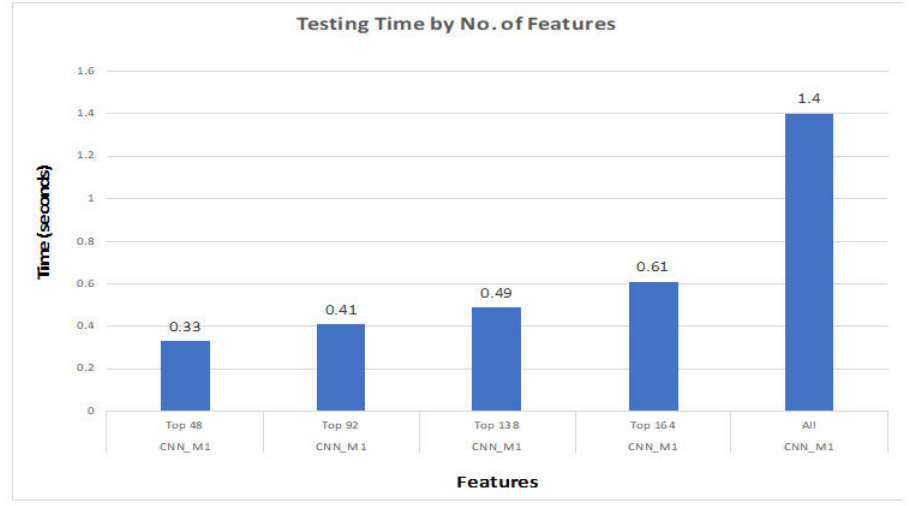
Figure 13. Testing time by number of features for